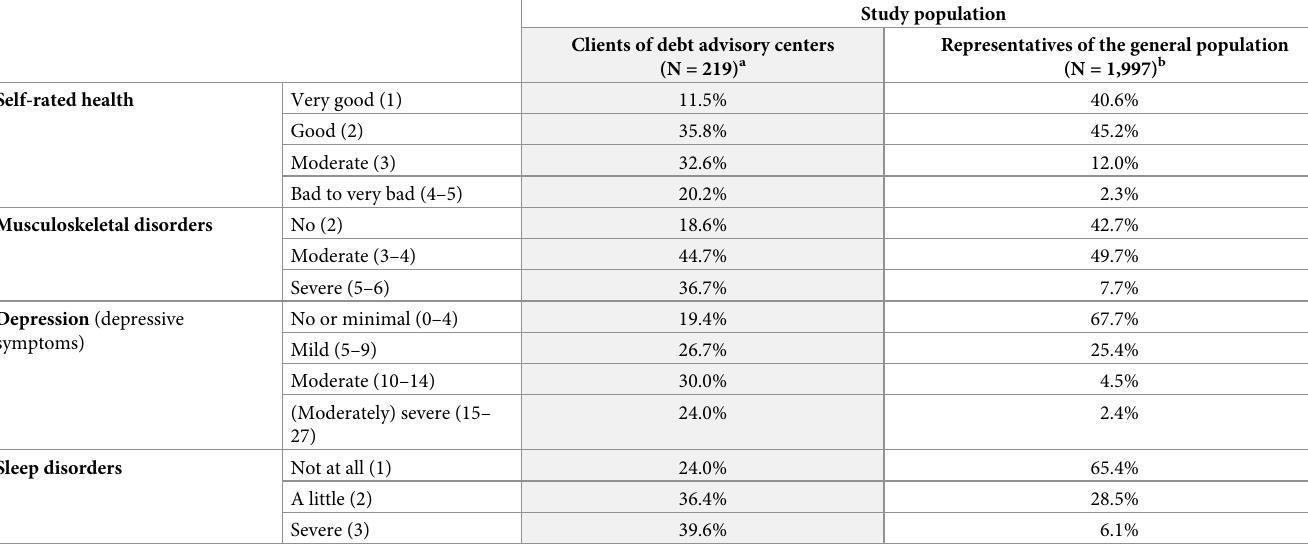
Table 2. Health-related characteristics of the study population, stratified by subsamples (N =